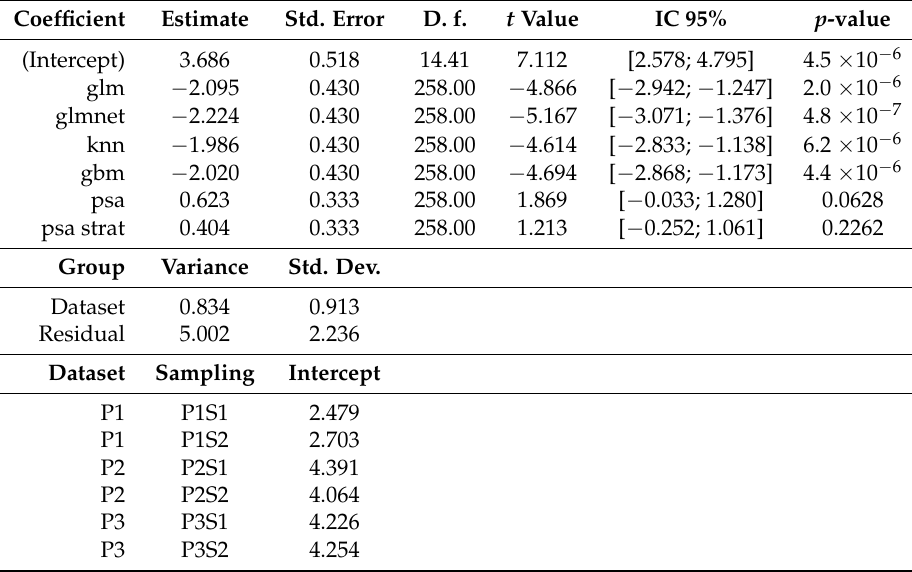
Table 3. Linear mixed-effects model on relative standard deviation considering adjustment methods and algorithms as fixed effects and datasets as random effects. Reference levels: treebag algorithm and Matching